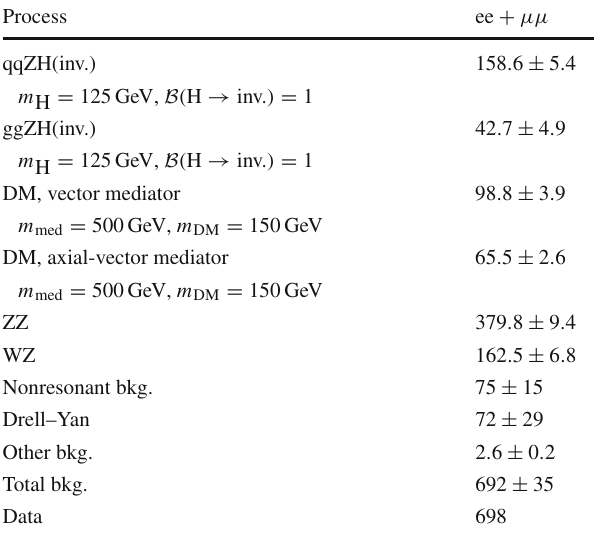
Table 3 Signal predictions, post-fit background estimates, and observed numbers of events in the p miss statistical and systematic uncertainties are reported Process qqZH(inv.)